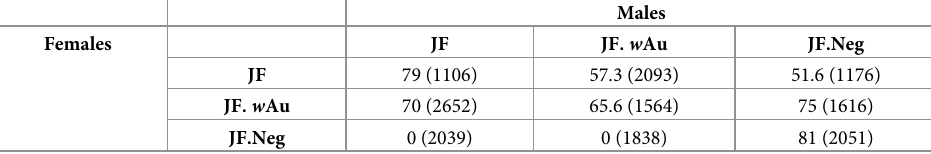
Table 1. Crosses and CI patterns. Wolbachia triple-strain (JF. w Au), wild-type (JF) and tetracycline-treated Ae .